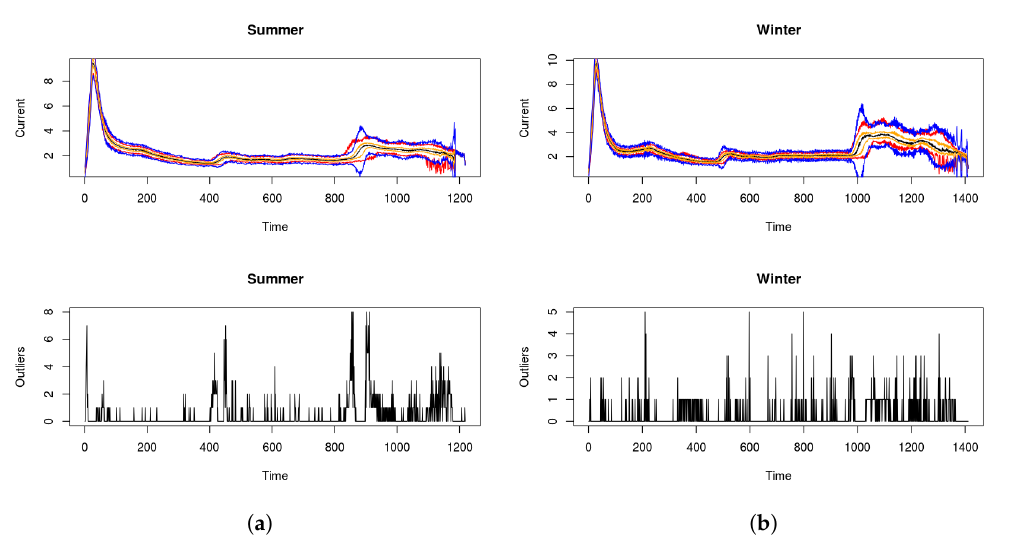
Figure 6. Data variability and outliers in ( a ) summer and ( b ) winter.